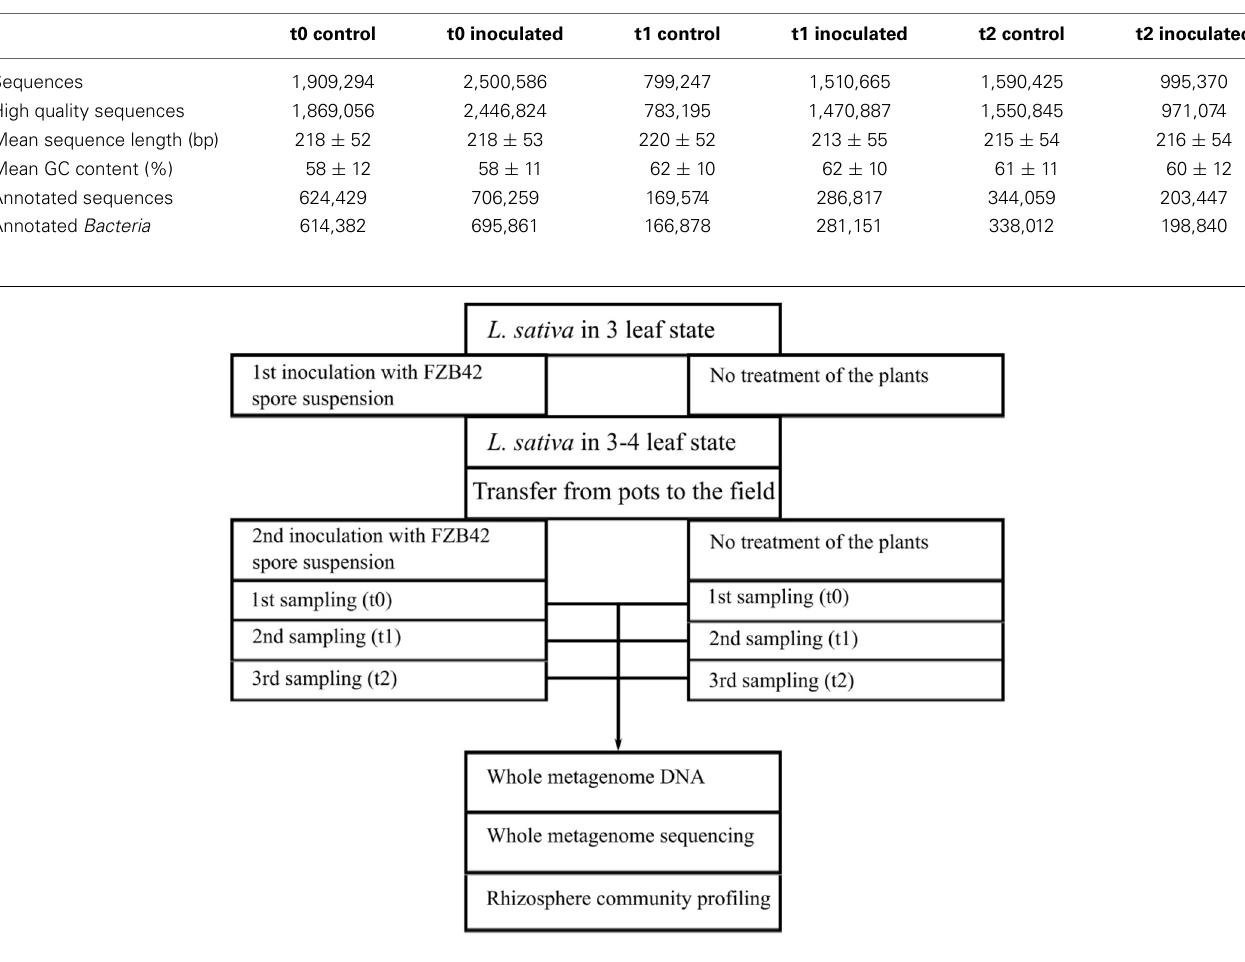
FIGURE 1 | Scheme of the lettuce field cultivation experiment. Lettuce was either inoculated with B. amyloliquefaciens FZB42 or not treated. Samples of both experiments were drawn at planting (t0), 2 weeks (t1), and 5 weeks (t2) of cultivation from the rhizosphere of the inoculated and